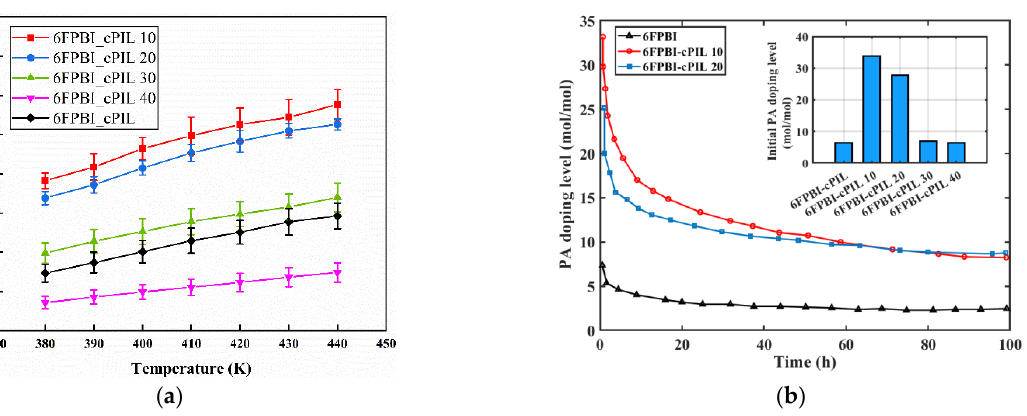
Figure 9. Performance of different membranes: ( a ) variation of proton conductivity with temperature; ( b ) variation of PA doping level with time.